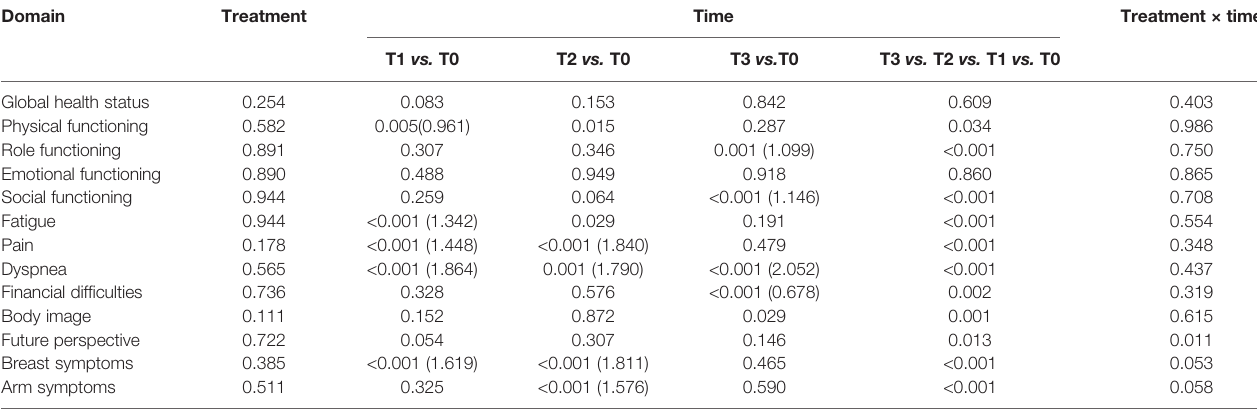
TABLE 4 | Summary of generalized estimating equation for quality-of-life outcomes, P values. Domain